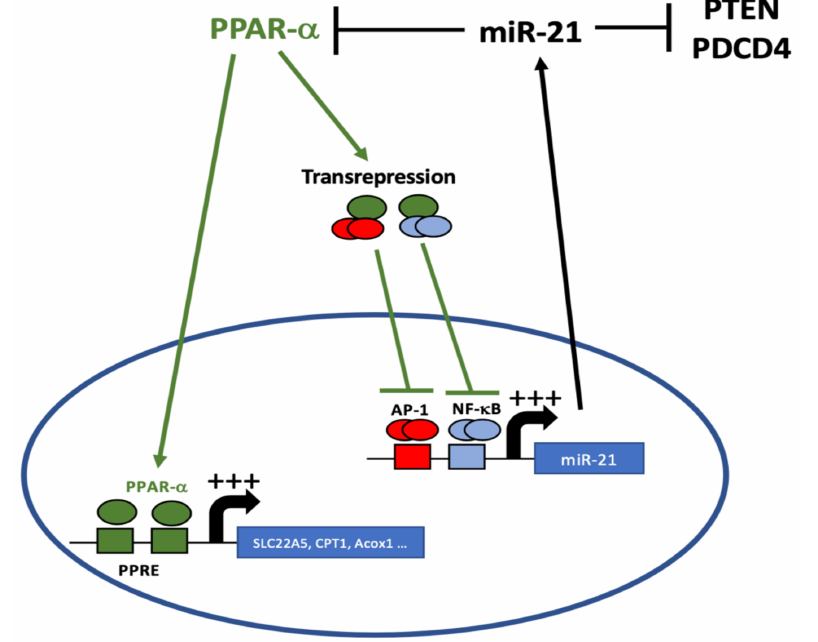
Figure 7. A double-negative feedback interaction between miR-21 and PPAR- α in clear renal cell